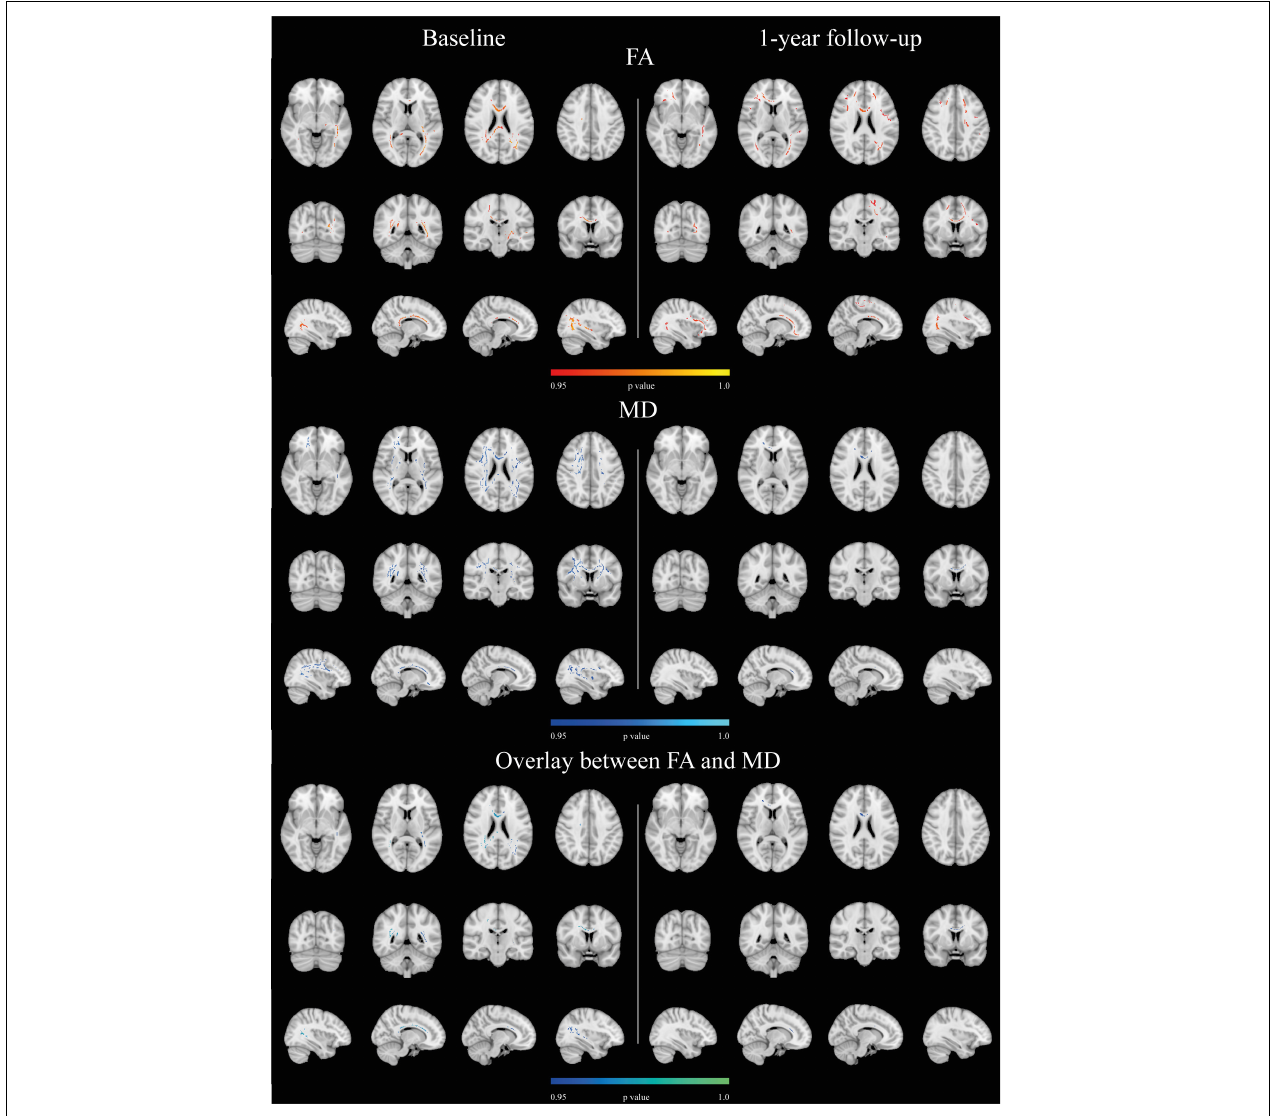
FIGURE 3 | Associations between CRF and DTI metrics. CRF associations with DTI parameters at baseline and at 1-year follow-up ( p ≤ 0.05, corrected for multiple comparisons, sex, and age). On the bottom row the overlap between FA and MD results. There were no significant results at the 3- or 5-year follow-ups. Results are superimposed on the standard MNI 152 1 mm template on radiological convention. Positive associations are reported in red-yellow, negative relationships in blue-light blue, and the overlap between significant FA and MD results is depicted in